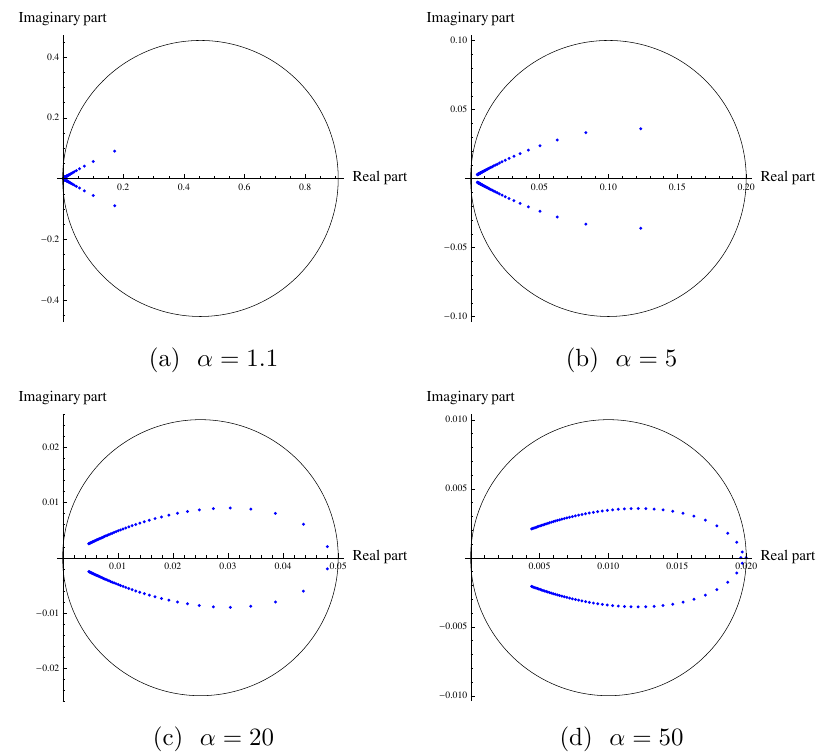
Figure 1. Eq. (4.4); eigenvalues of D i , i = 1 , 2 ,... ; linear spline collocation with Gauss